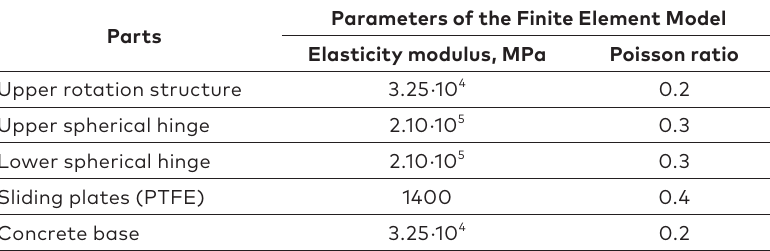
Table 1. Material parameters of the Finite Element